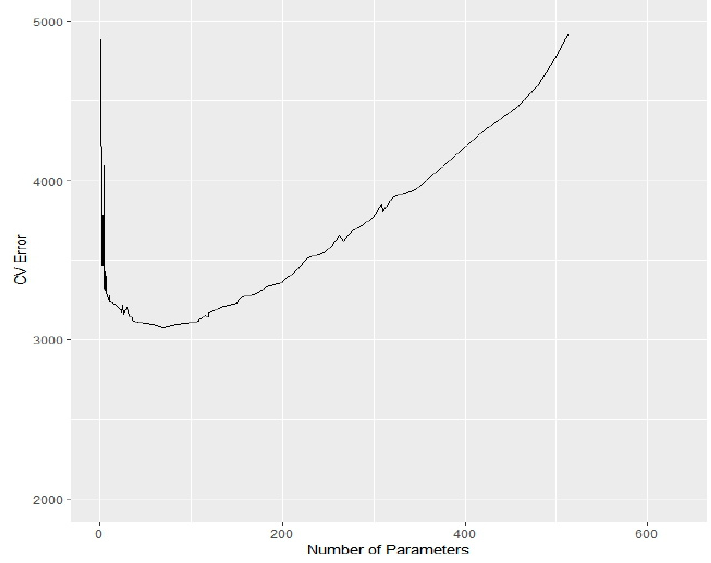
Figure 3. An example of cross-validation error.